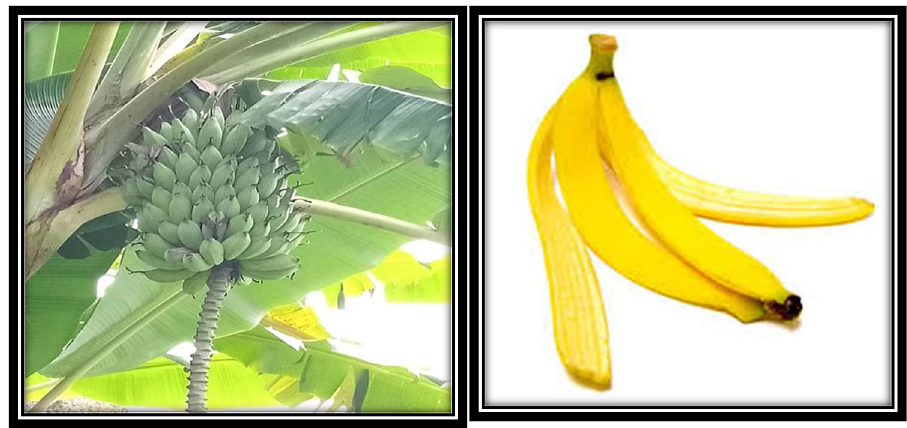
Figure 1. Banana plant with fruit taken from Ethiopian country, Oromia region, Gudaya Bila.